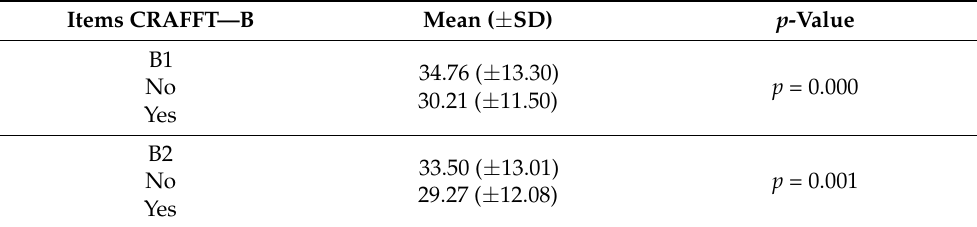
Table 3. Age (years) differences in terms of consequences of substance use